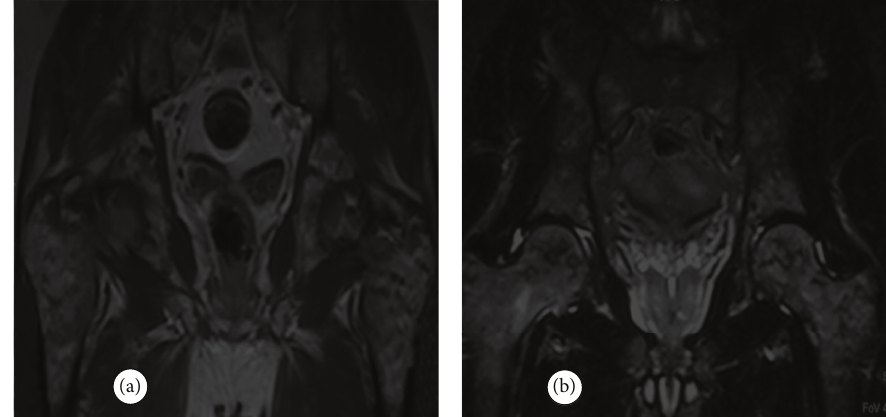
Figure 2: MRI scan of pelvis and both femurs showed multiple metastatic bone lesions dominantly located in both femoral heads, necks, and trochanters with a largest of diameter 2 cm. (a) Multiple hypointense metastatic bone lesions on T1-weighted coronal imaging. (b) Multiple hyperintense metastatic bone lesions on T2-weighted coronal